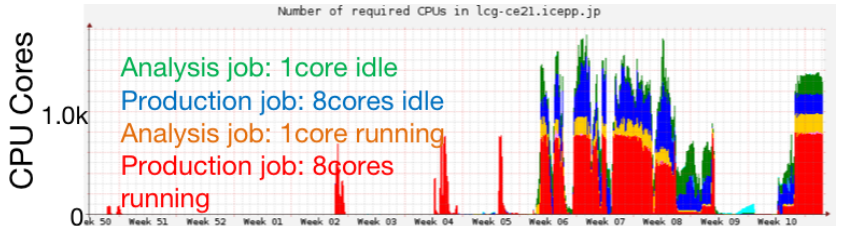
Figure 4. Test jobs running on the hybrid system using GCP.